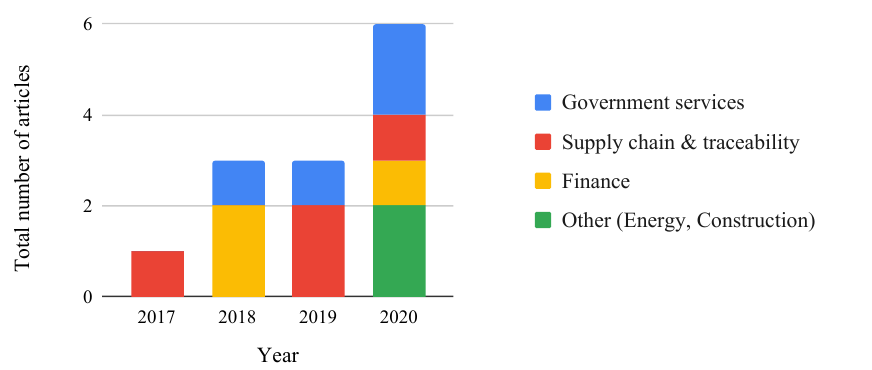
Figure 6. A trend of domains of blockchain research in Thailand between 2017 and 2020.